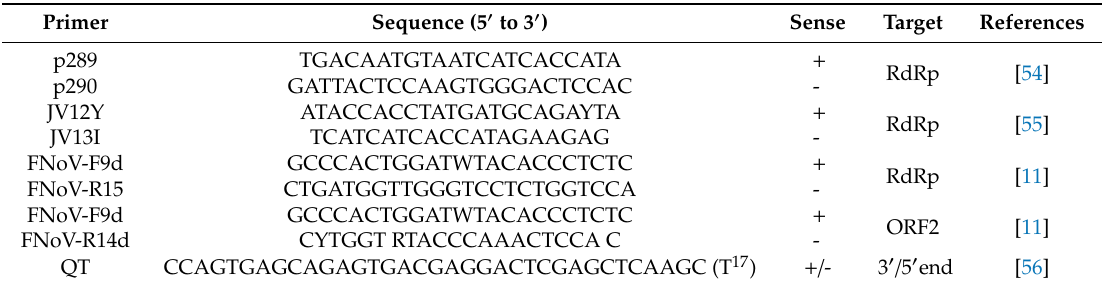
Table 2. List of primers used for detection of feline